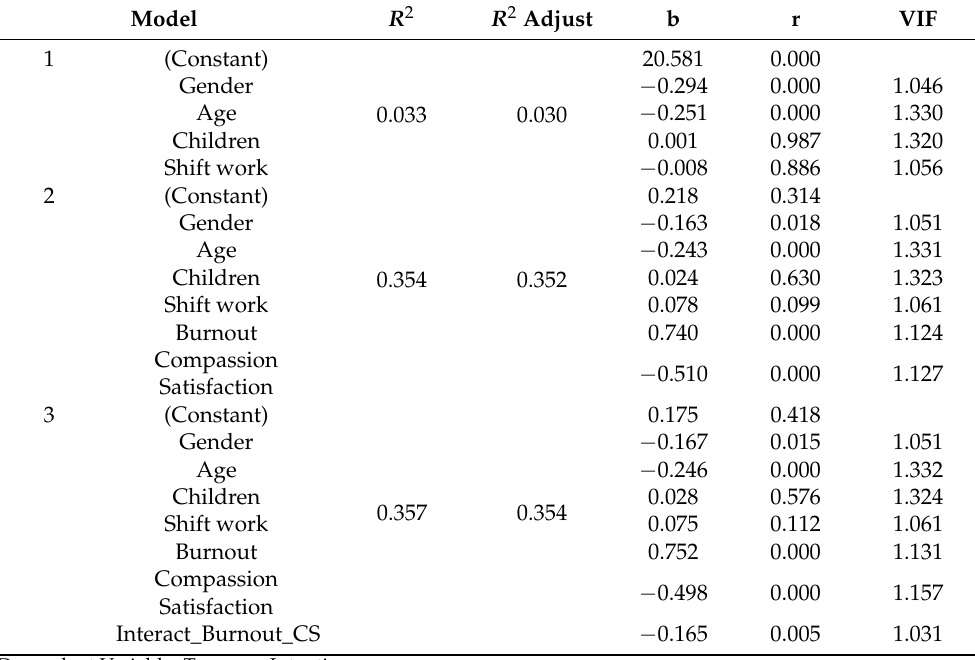
Table 3. Regression between Burnout, Turnover Intention and Compassion